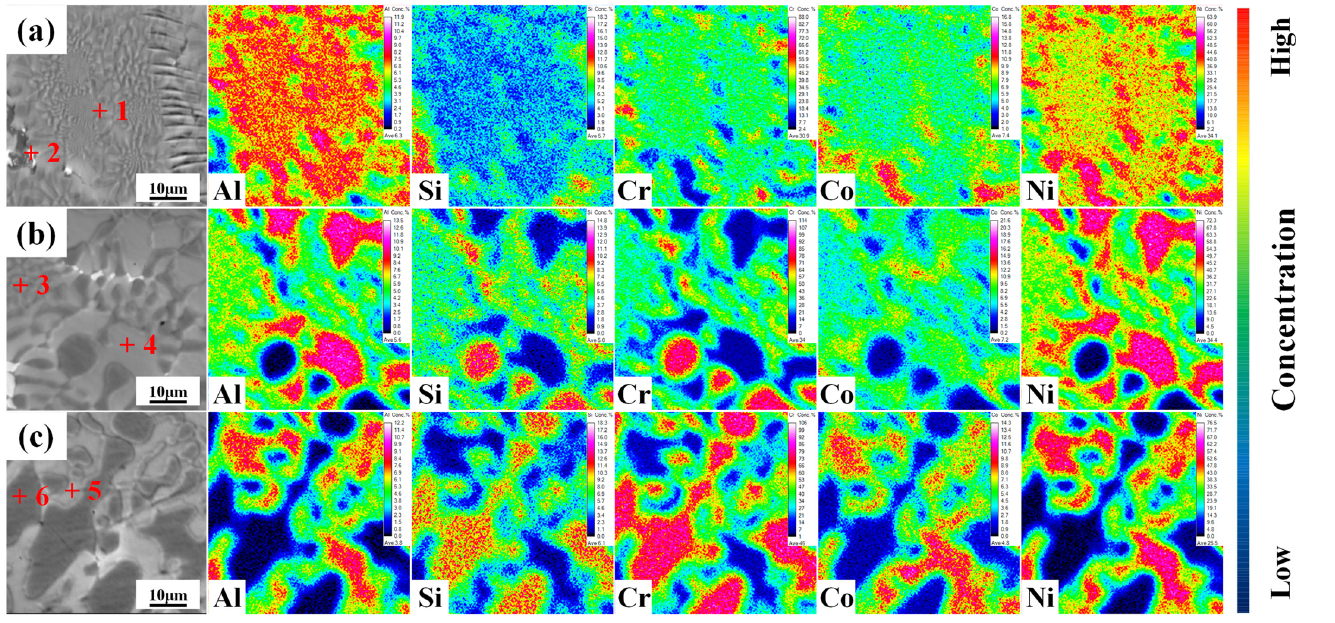
Figure 4. EPMA analysis of AlSi 0.5 Cr x Co 0.2 Ni high entropy alloys; ( a ) x = 1.0, ( b ) x = 1.4, ( c ) x = 1.8. Table 3. Point scanning results of EPMA relevant to Figure 4.